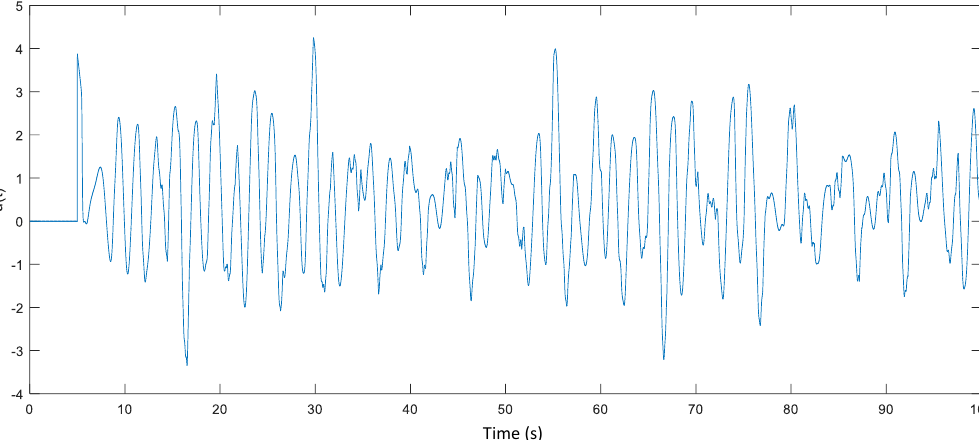
Figure 6. Control signal based on the proposed robust adaptive control strategy (11) where it is activated at 𝑡 = 5 s .